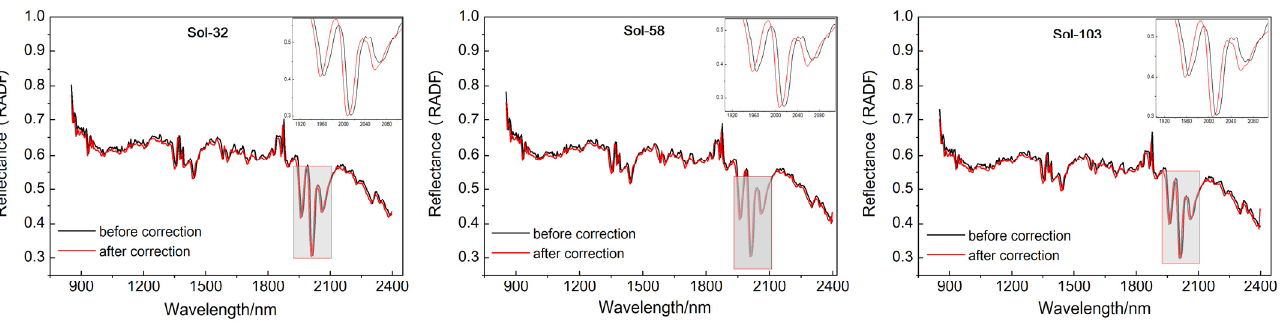
Figure 8. White panel RADF reflectance curves before and after calibration of three sols’ spectra (black curve indicates before calibration; red indicates after calibration).